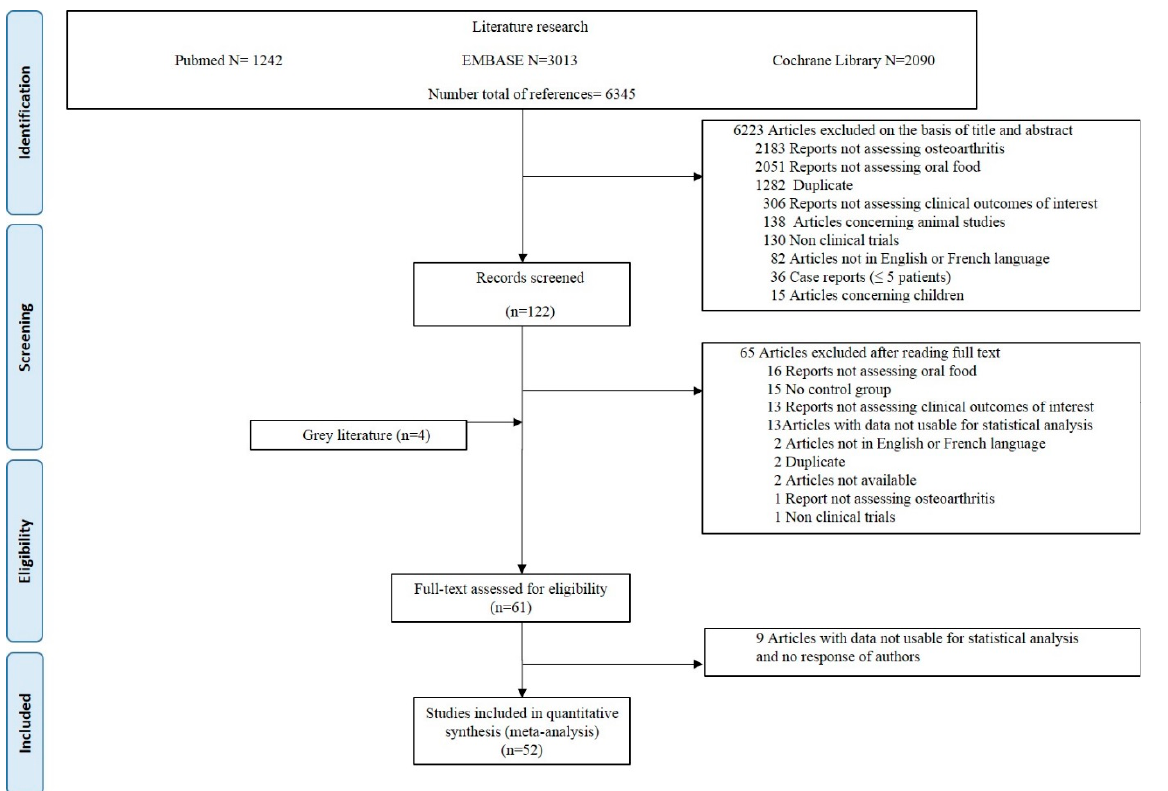
Figure 1. Preferred Reporting Items for Systematic reviews and Meta-Analysis (PRISMA) diagram .